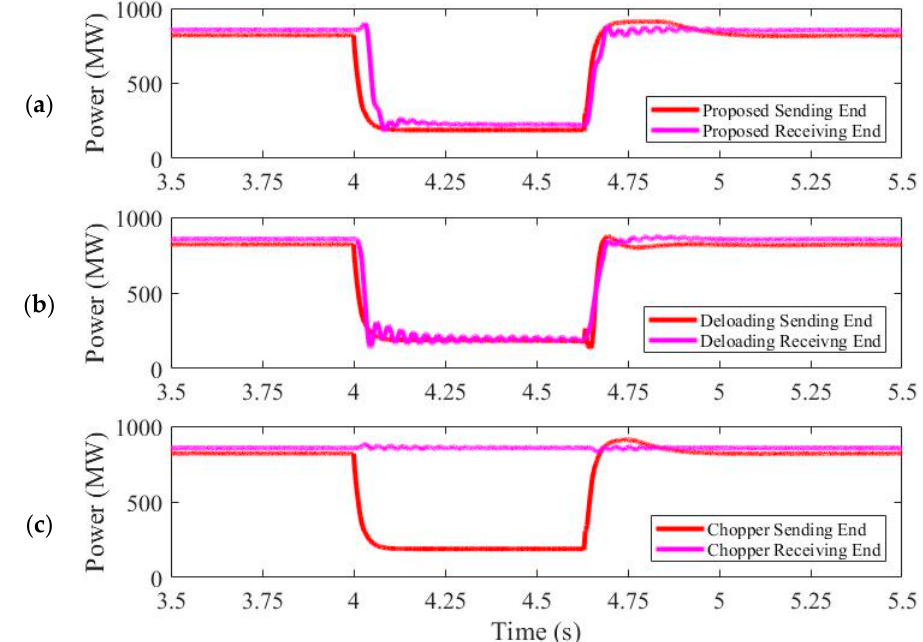
Figure 15. Simulation results of the on-shore fault scenario with a 2.95 Ω fault resistance. ( a ) On-shore AC voltage for each simulation case. ( b ) Off-shore AC voltage for each simulation case. ( c ) Rectifier-side DC voltage for each simulation case.